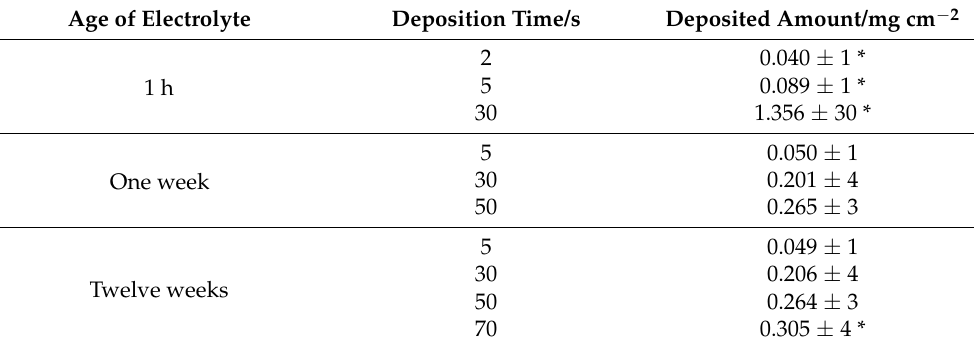
Table 2. Dependence of deposited amount of Ex-CN US on the time of electrophoretic deposition and the age of the Ex-CN US suspension used. Age of